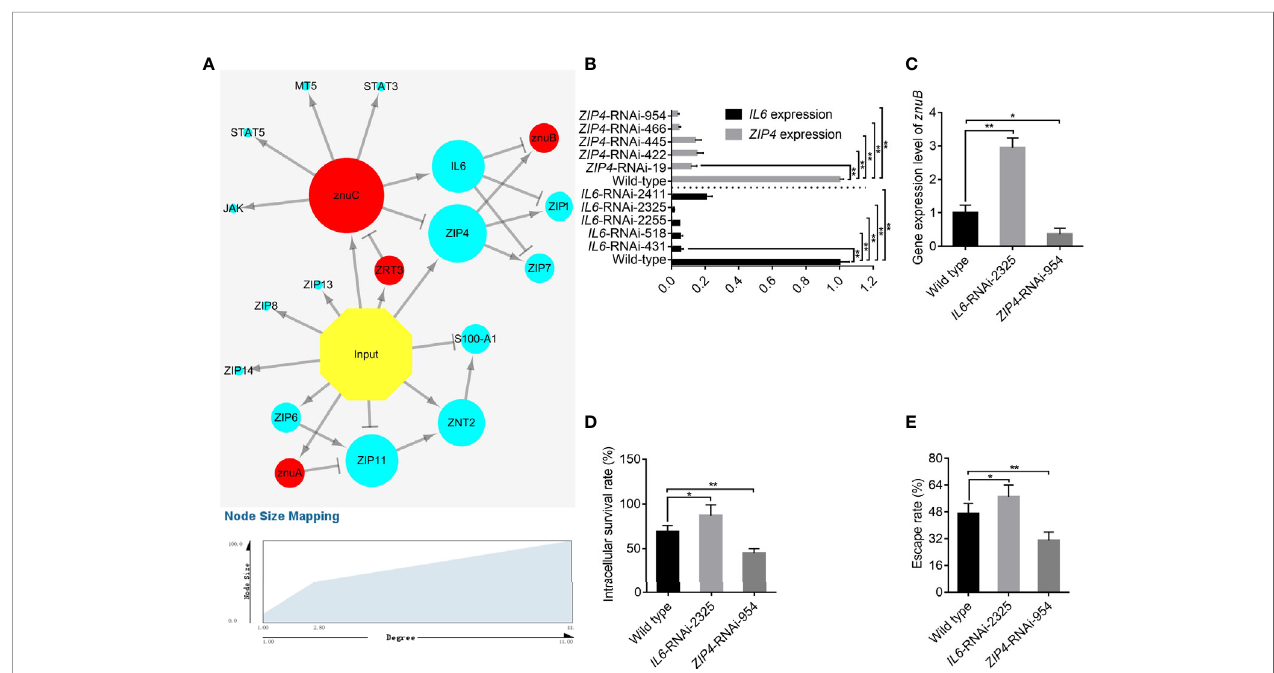
FIGURE 5 | IL6 and ZIP4 play key roles in the trade-off for Zinc (Zn) between Epinephelus coioides and Pseudomonas plecoglossicida . (A) Predicted regulation network among E. coioides Zn nutritional immunity related genes and P. plecoglossicida Zn acquisition genes. Occurrence of infection, E. coioides genes and P. plecoglossicida genes are colored in yellow, blue and red, respectively. Positive and negative correlations are represented by lines. (B) To characterize the importance of IL6 and ZIP4 , fi ve IL6 -RNAi and ZIP4 -RNAi E. coioides macrophages were constructed, and the silencing ef fi ciencies were validated by quantitative real time PCR (qRT-PCR). (C) According to the pathogen-host gene regulatory network, IL6 and ZIP4 were supposed to promote and repress znuB expression, respectively. To validate this, qRT-PCR was carried out on wild type, IL6 -RNAi-2325 and ZIP4 -RNAi-954 E. coioides macrophages. (D, E) In order to validate whether the IL6 and ZIP4 in E. coioides macrophages is important for intracellular killing of P. plecoglossicida , the intracellular viability and immune escape of wild type P. plecoglossicida was compared in wild type, IL6 -RNAi-2325 and ZIP4 -RNAi-954 E. coioides macrophages. Values are mean ± SD (n = 3, * P < 0.05, ** P <